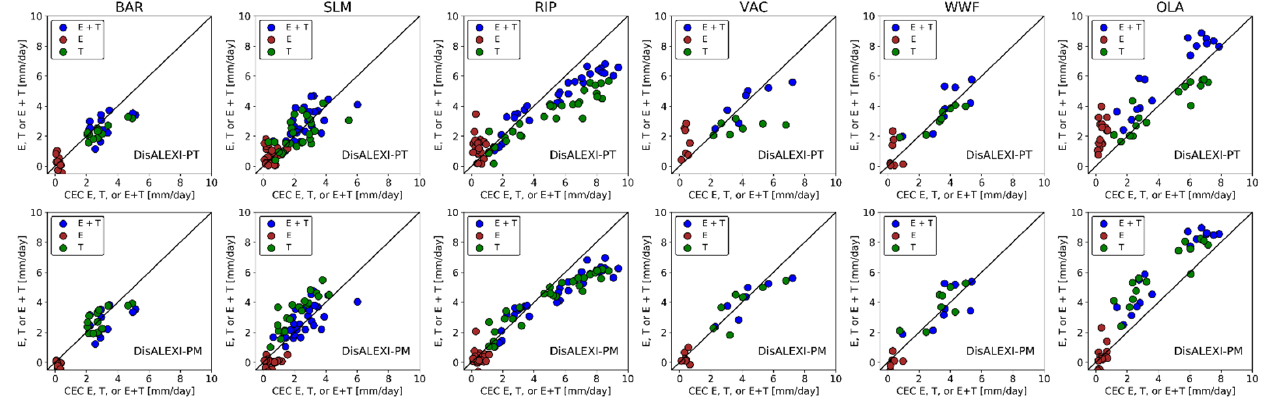
Figure 5. Scatter plots of DisALEXI-PT- ( top ) and DisALEXI-PM ( bottom )-derived E, T, and ET (y-axis) versus CEC E, T, and ET (x-axis) for all sites on clear Landsat overpass dates during 2021. Table 2. Statistical metrics correlation coefficient (R 2 ), root mean square error (RMSE), and mean bias error (MBE) for DisALEXI-PT (PT) and DisALEXI-PM (PM) partitioned evaporation (E), transpiration (T), and combined E and T compared to CEC-derived E and T and combined E and T for all sites. E T E + T PT PM